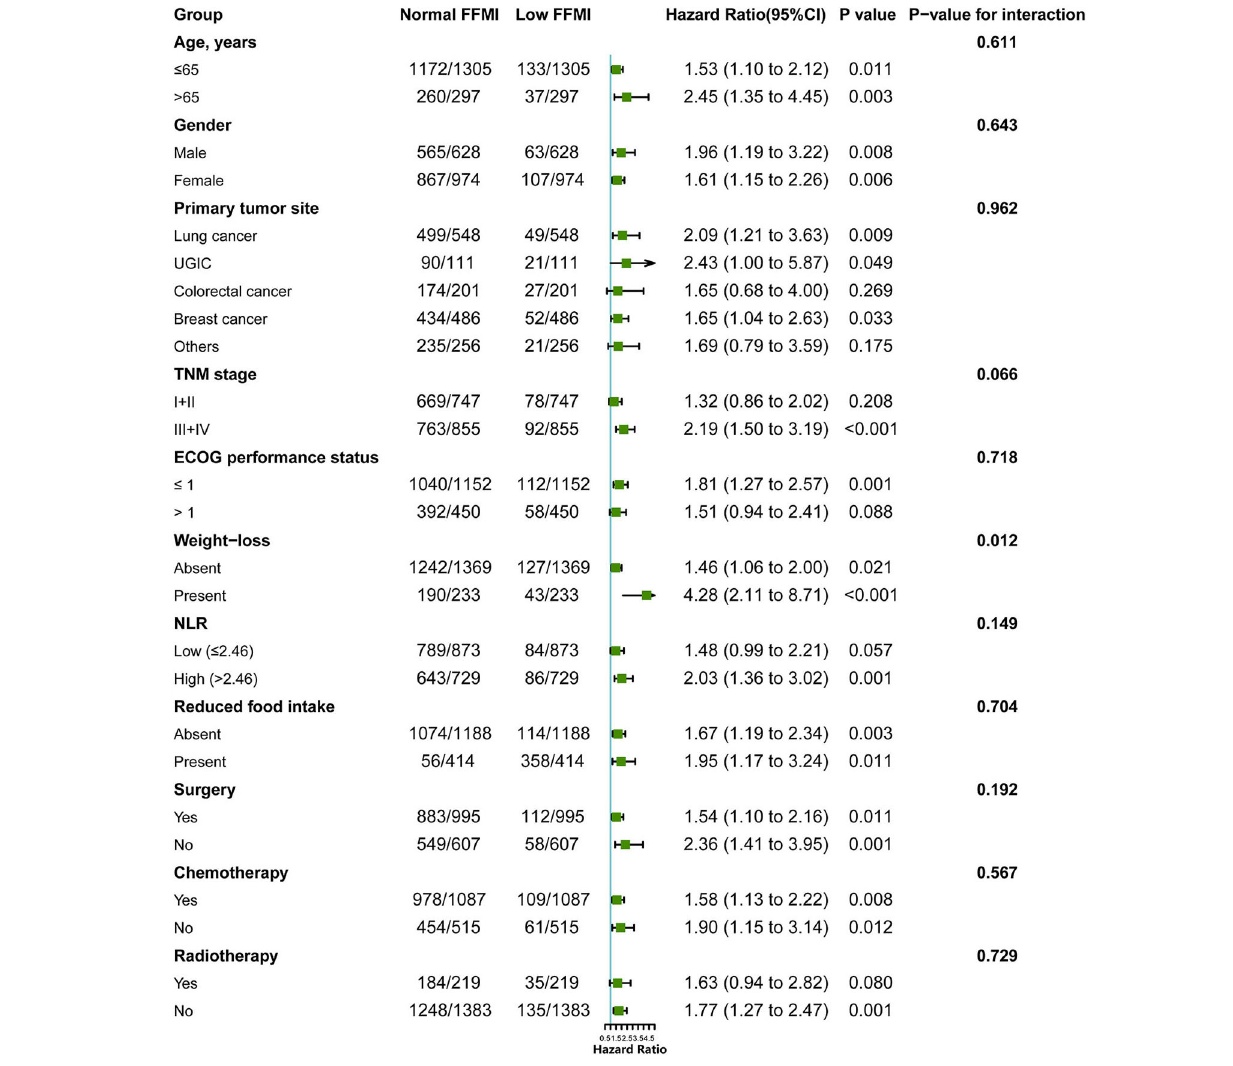
FIGURE 3 | Subgroup analysis for evaluating the prognostic effect of FFMI on OS in cancer patients with normal/high BMI. FFMI, fat free mass index; UGIC, upper gastrointestinal cancer; ECOG, Eastern Cooperative Oncology Group; NLR, neutrophil-to-lymphocyte ratio. Adjusted for tumor type, ECOG performance status, TNM stage, reduced food intake and